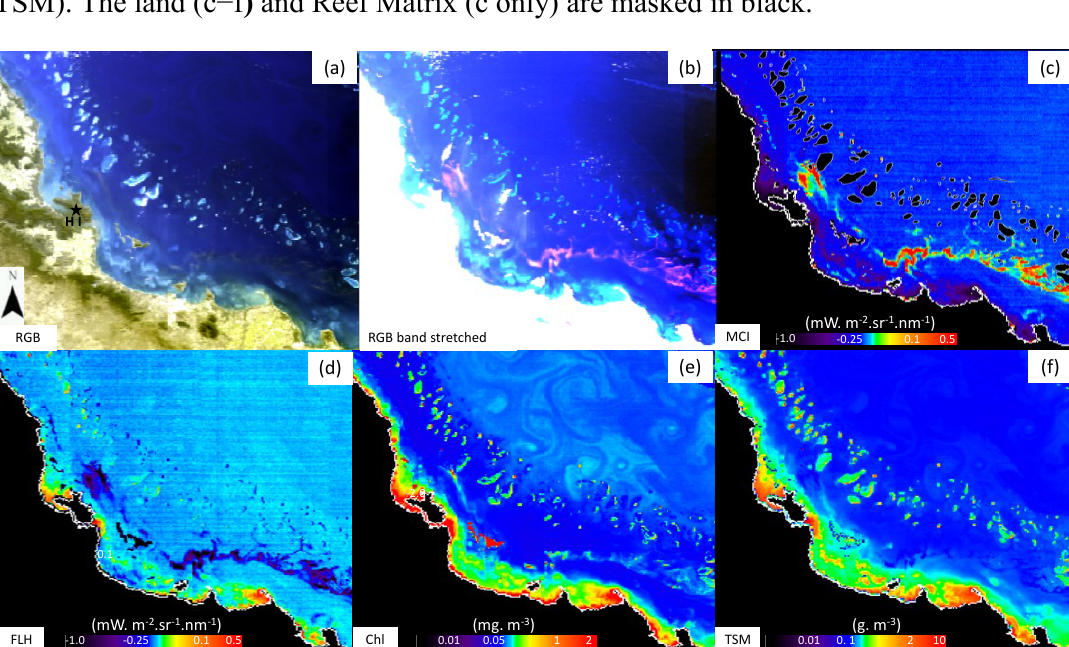
Figure 2. MEdium Resolution Imaging Spectrometer (MERIS) scene of 30 July 2008 for the Great Barrier Reef Wet tropics (GBRW), illustrating the potential of multiple MERIS products for algal blooms monitoring. A surface bloom occurs near Hinchinbrook Isl. (18.5°S; black star in (a)). The four MERIS products used for this study are shown. ( a ) RGB BEAM Tristimulus; ( b ) a band stretched image with MERIS bands 10, 7, 5; ( c ) Maximum Chlorophyll Index (MCI); ( d ) Fluorescence Line Height (FLH); ( e ) Free University Berlin (FUB) Chlorophyll-a (Chl) (algal 2) and ( f ) FUB Total Suspended Matter (TSM). The land (c−f ) and Reef Matrix (c only) are masked in